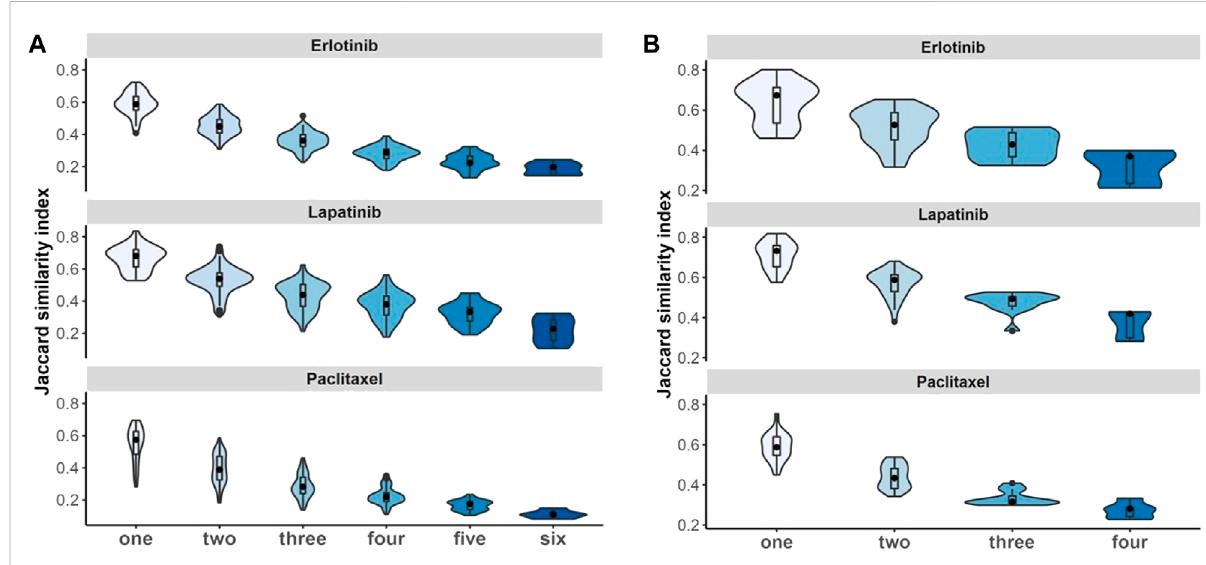
FIGURE 7 Non-independent studies meta-analyses and biomarker discovery. Violin plots illustrate stability of identi fi ed 100 top-ranked genes associated with drugs by increasing the number of duplications using Jaccard similarity index using (A) breast cancer and (B) pan-cancer data. Black dot at the box plot represents the median. Note that the x -axis presents the number of duplicate study